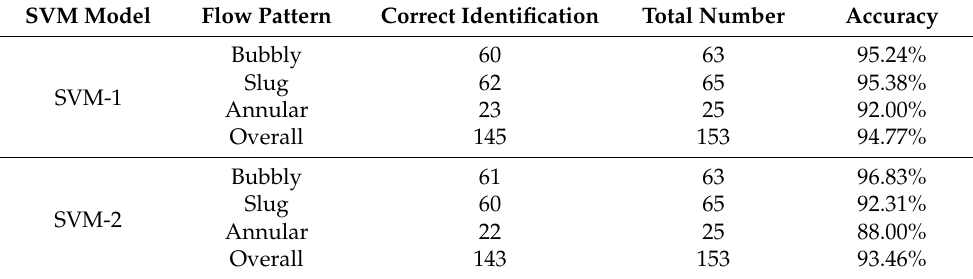
Table 8. The identification results of SVM models.